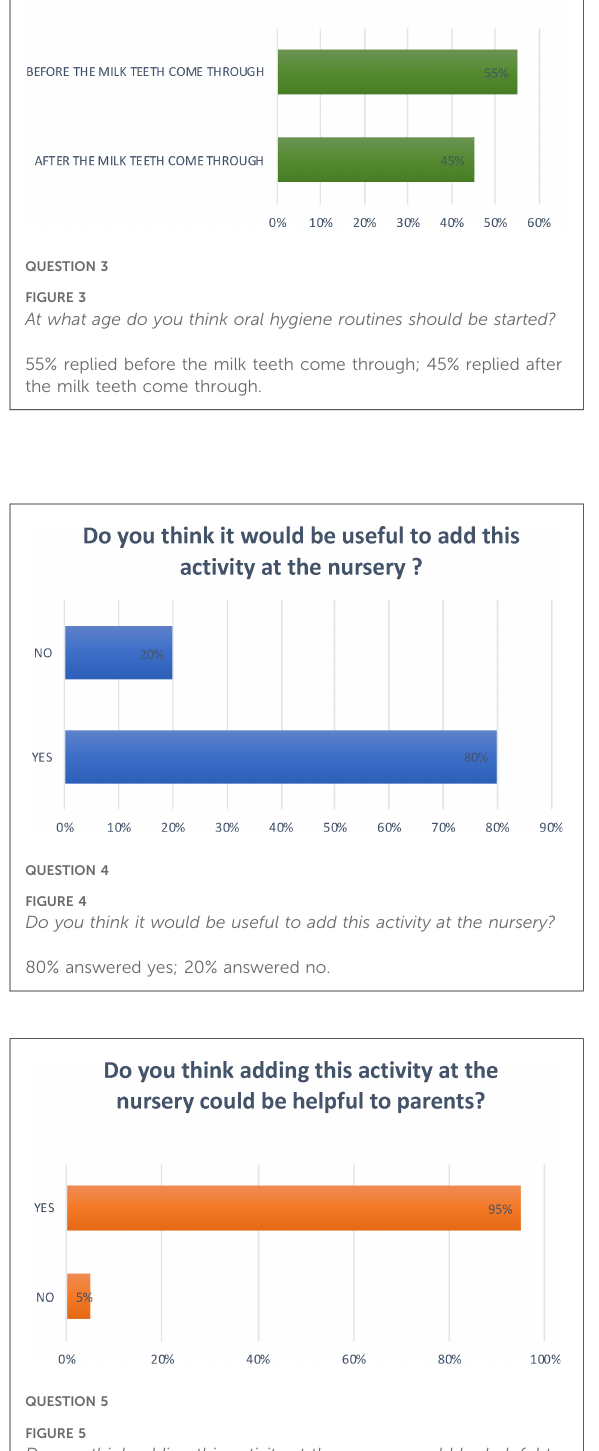
FIGURE 5 Do you think adding this activity at the nursery could be helpful to parents? 95% answered yes; 5% answered no.